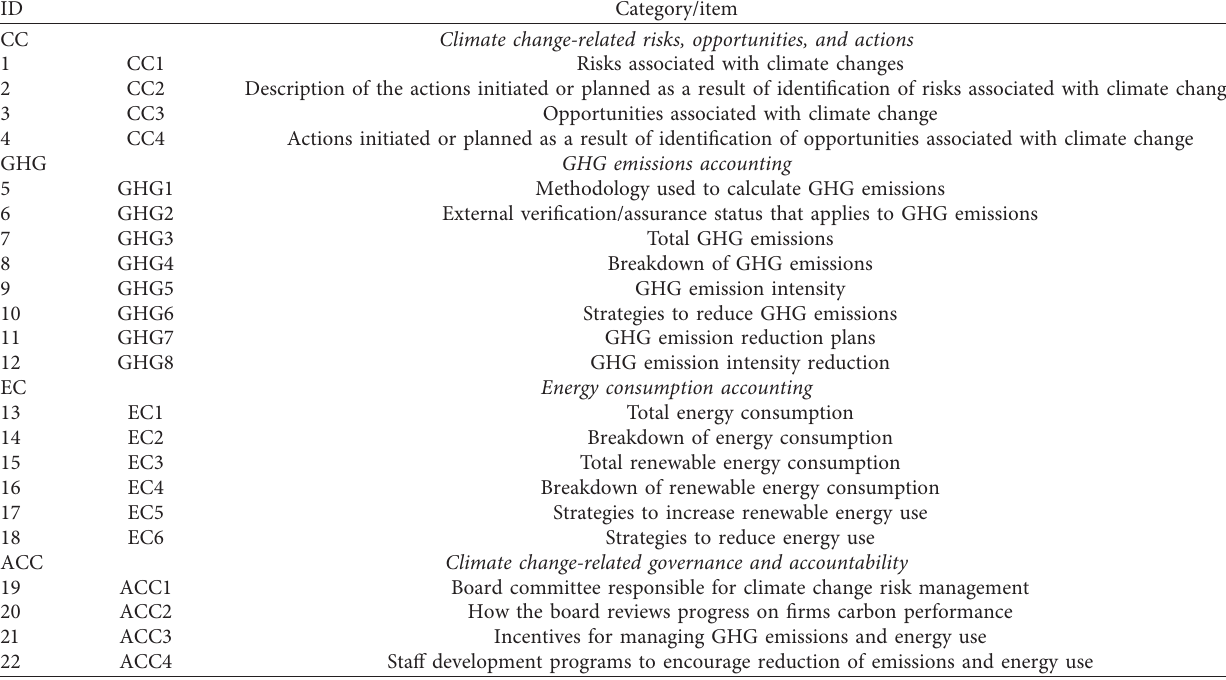
Table 1: Items included in the carbon information disclosure index.